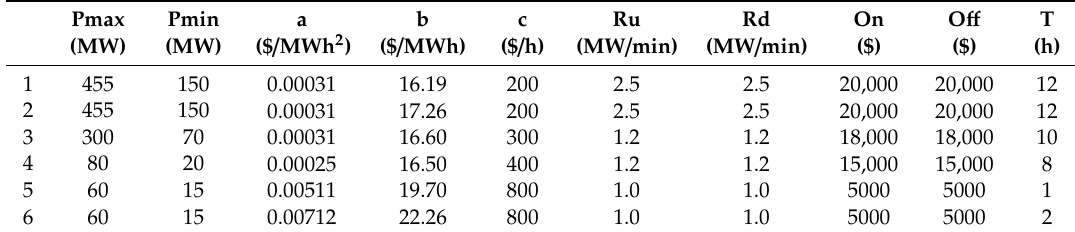
Table A1. The parameters of units.